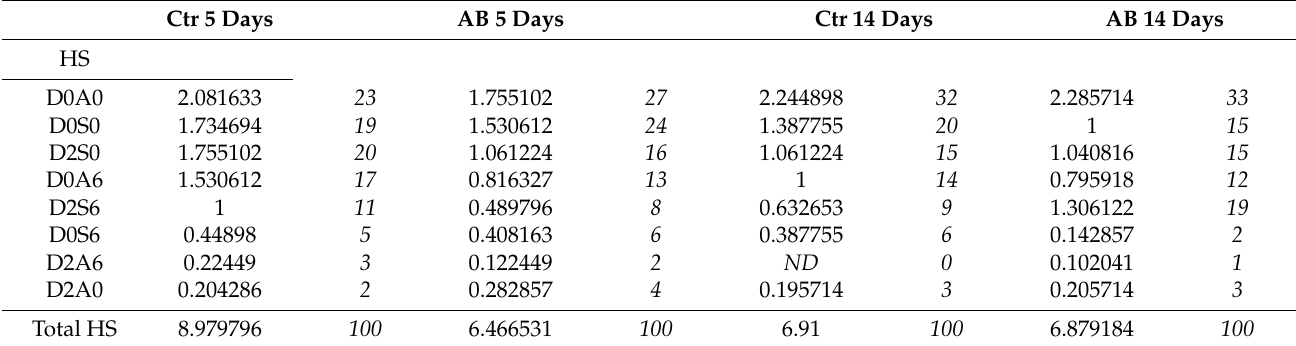
Values represent µ g per cornea Percentage ( w / w ). ND = below the limits of